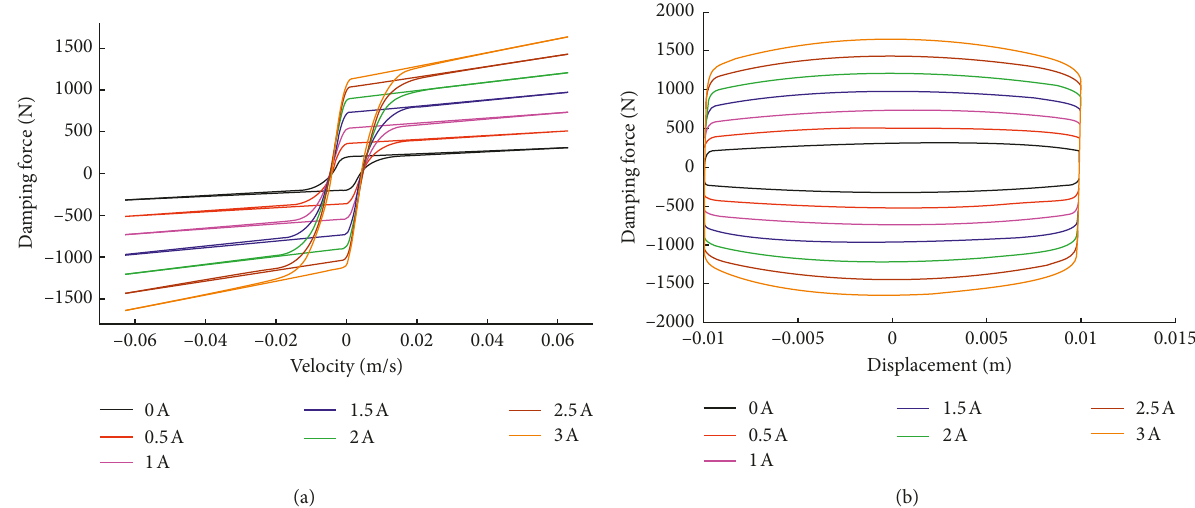
0.01m, f 1Hz under different currents. (a) Piston speed at different currents-damping force curve. (cid:31) (cid:31)